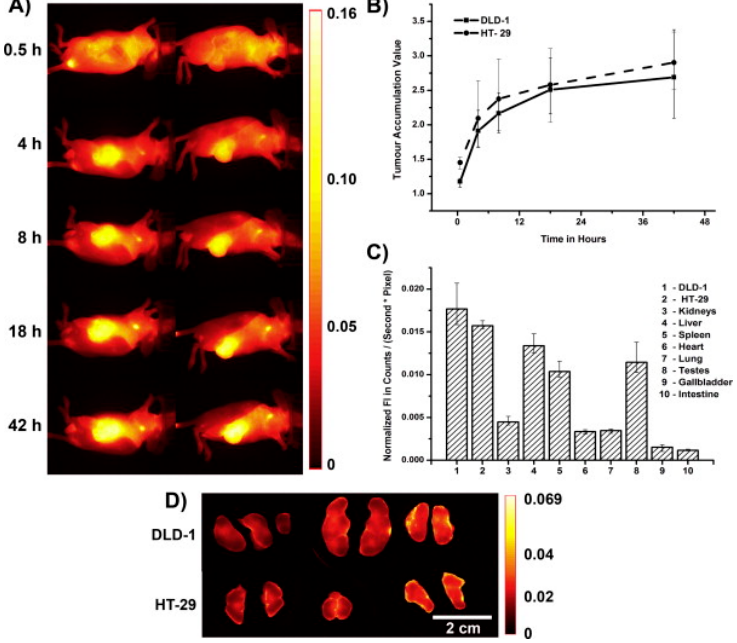
Figure 7. ( A ) In vivo images of colon carcinoma xenograft-bearing mouse after injection of 1.5